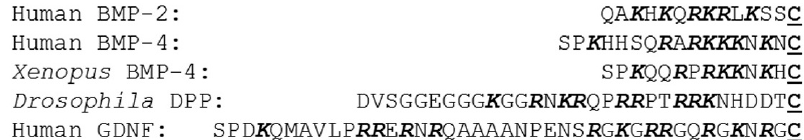
Figure 3. N -terminal sequences of some heparin binding BMPs. The sequences are shown ending with the first cysteine (shown in bold underlined font at the right hand side) of the knot domain. The basic residues lysine and arginine are highlighted in bold italics, and sequence regions experimentally implicated in heparin binding are boxed.